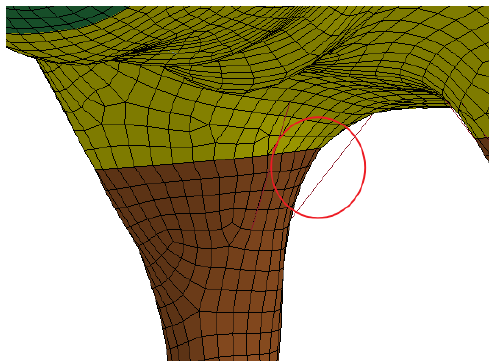
Figure 8. Ligamentous elements of living invader.